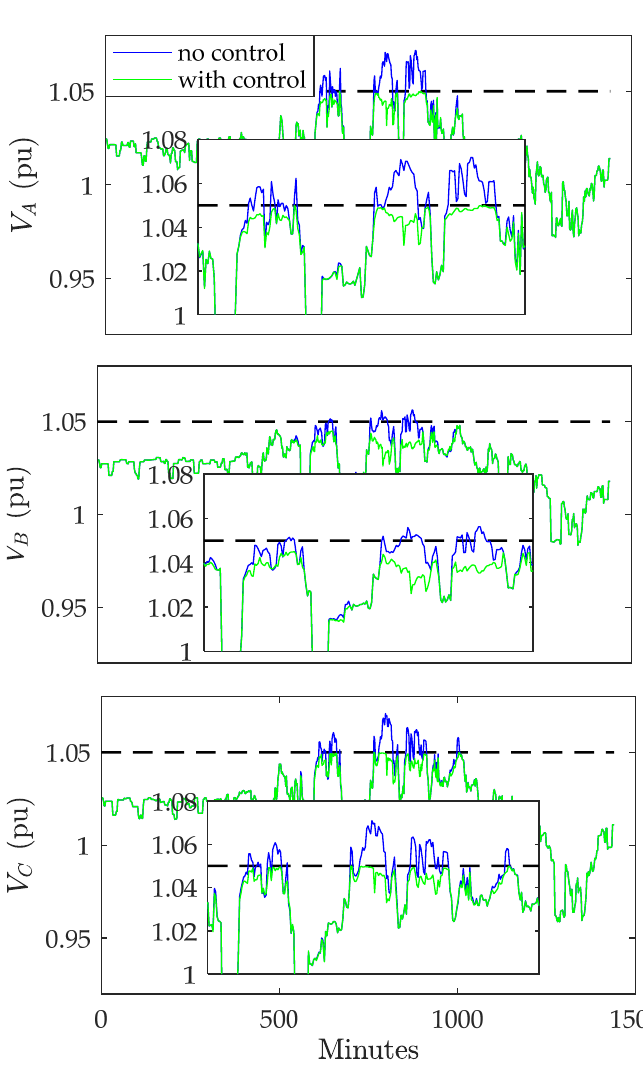
Figure 14. Voltage on lateral 5 without and with control.